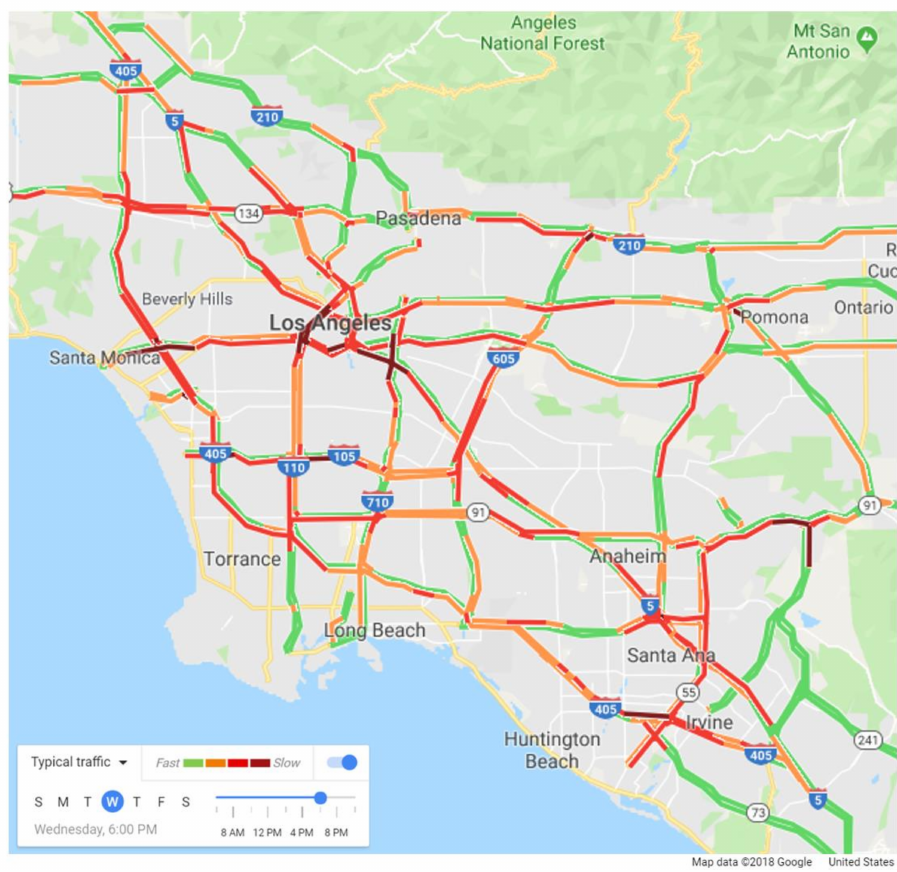
Figure 3. A screenshot of a map of typical traffic congestion levels at 6 P.M. on Wednesday in the Los Angeles Metropolitan Area (Source: Google